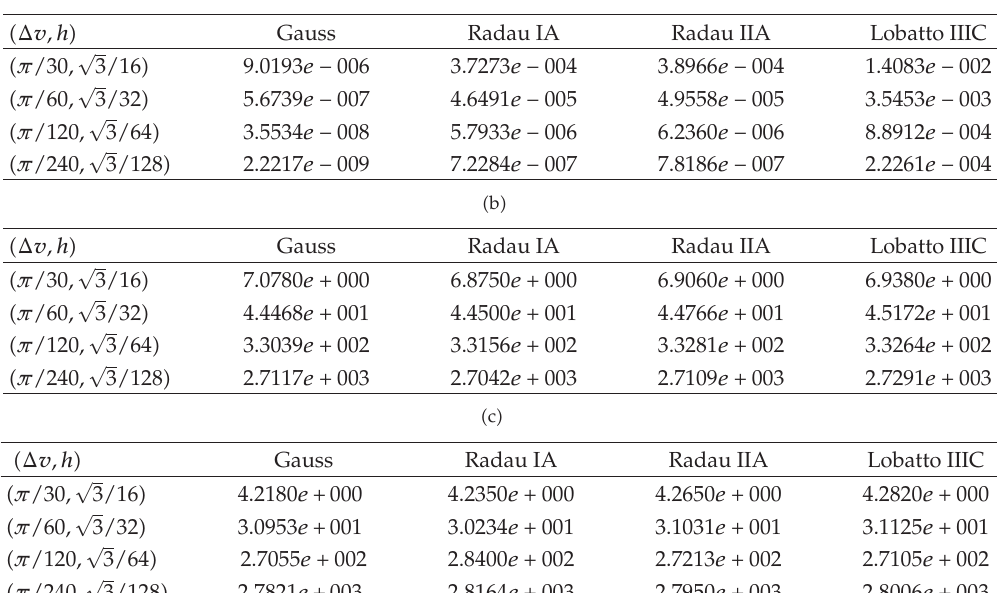
Table 2: (cid:3) a (cid:4) The errors of the numerical solutions of (cid:3) 2.22 (cid:4) by methods { (cid:3) 7.1 (cid:4) , (cid:3) 3.10 (cid:4) } , (cid:3) b (cid:4) The CPU times (cid:3) in second (cid:4) of methods (cid:3) 3.7 (cid:4) – (cid:3) 3.10 (cid:4) for (cid:3) 2.23 (cid:4) and (cid:3) c (cid:4) The CPU times (cid:3) in second (cid:4) of methods { (cid:3) 7.1 (cid:4) , (cid:3) 3.10 (cid:4) } for (cid:3) 2.23 (cid:4)